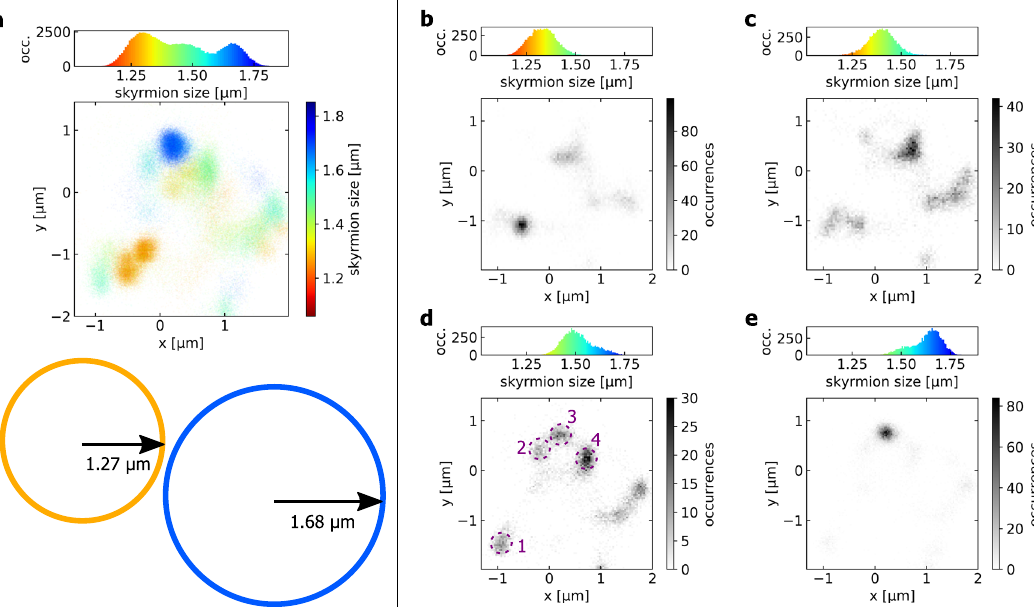
Fig. 2 Skyrmion size dependence of the pinning. a Skyrmion occurrences in all measurements at fi elds between − 43 and − 31 µ T with an average skyrmion size between 1.27 and 1.68 µ m with standard deviations of about 5%. Every detected skyrmion is depicted by a scatter plot point at the coordinate of observation. The colors represent the skyrmion size. The color intensity indicates the probability density of fi nding a skyrmion at a certain position. The top histogram shows the size distribution of all observed skyrmions. The colored circles on the bottom indicate schematically the size relation of the skyrmions among each other and the coordinate frame. b – e Histograms of the occurring skyrmion center positions in the same sample area at external fi elds of ( b ) − 39 µ T, ( c ) − 37 µ T, ( d ) − 35 µ T, and ( e ) − 33 µ T. The greyscale denotes the number of skyrmion center occurrences at a position. Even for small fi eld changes of 2 µ T corresponding to size changes of 5 – 8% in region depicted by ( b – e ), the skyrmion distribution varies drastically and skyrmions are pinned at different positions indicating size-dependent pinning sites. In ( d ), predominant pinning sites are highlighted by the dashed purple circles and labelled with integers 1 – 4.